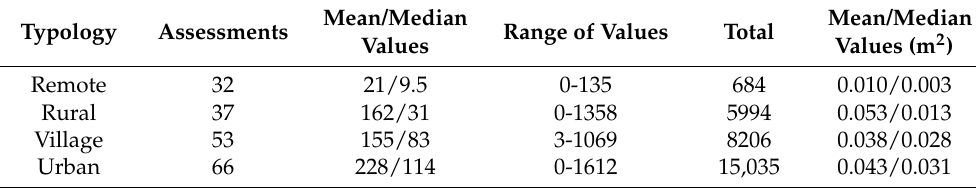
Table 3. Number of assessments, mean and median CB values per beach